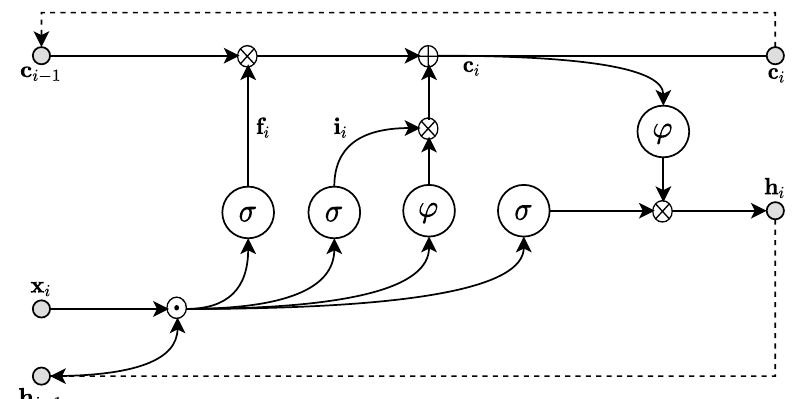
Figure 1. Overview of the LSTM